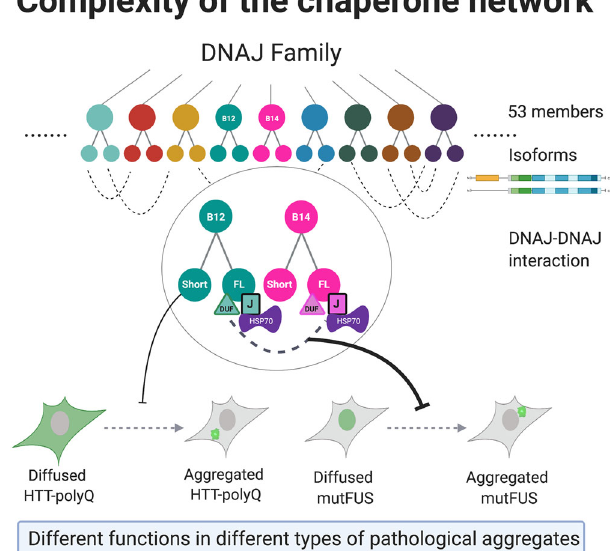
Fig. 8 Chaperone network complexity conferred by DNAJ isoforms and their differential functions. Naturally-occurring DNAJ isoforms and their interactions show differential functions with respect to different aggregate types, revealing inter-family functional diversi fi cation, thereby increasing the complexity of the chaperone network. Created with